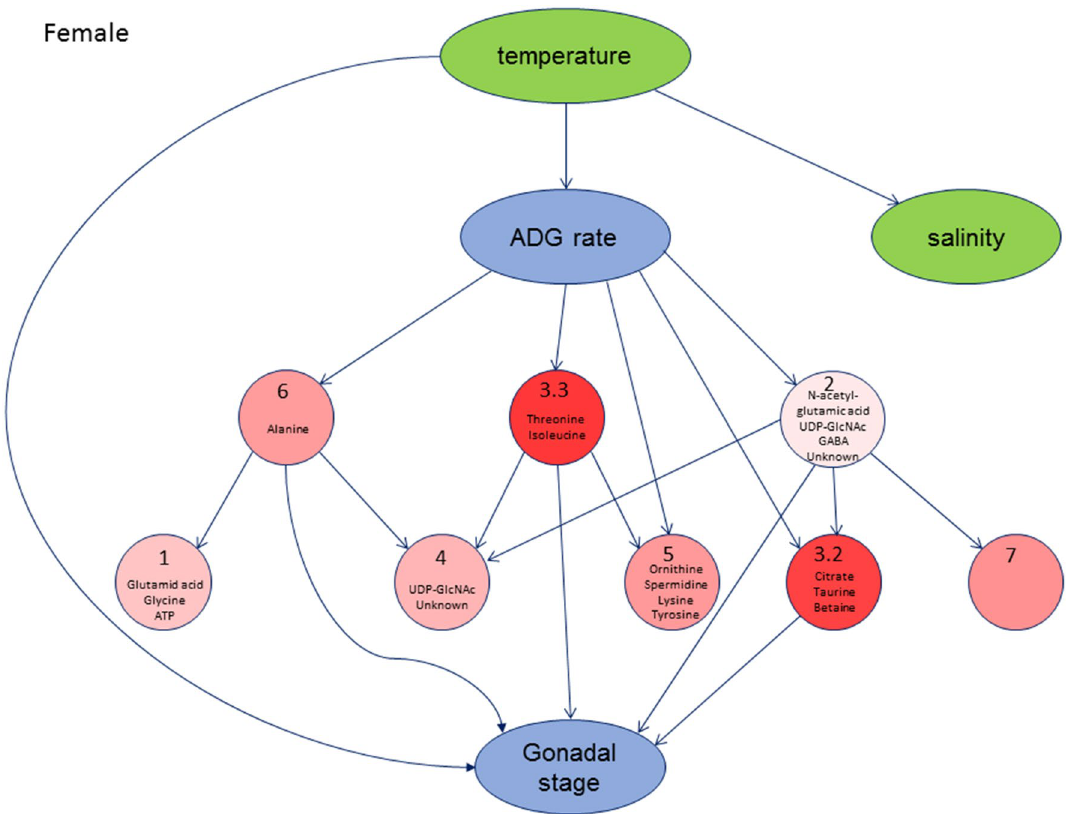
Figure 4. Dynamical TDARACNE model of the female mussels sampled from Exmouth (reference site). Red nodes represent metabolite clusters, green nodes environmental variables and blue nodes physiological variables. Intensity of red shows the percentage of metabolites significantly different (FDR 1e-8) between